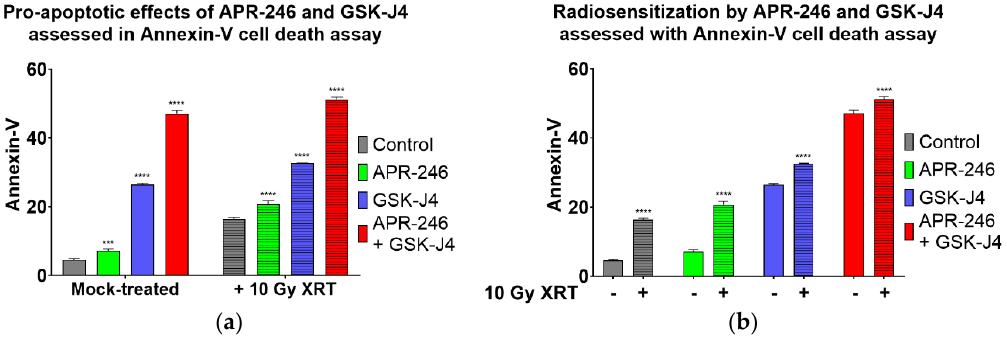
Figure 6. APR-246 combined with GSK-J4 induces apoptosis of H3.3 K27M DIPG cells following radiation treatment. Annexin V apoptosis assay with SF8628 H3.3 K27M DIPG cells. ( a ) Pro-apoptotic effects of APR-246 and GSK-J4 used as single agents (open bars on the left) or combined with XRT (crossed bars on the right), versus untreated cells; ( b ) Same experiment evaluating radiosensitization by comparing % Annexin-V cells treated with 10 Gy XRT vs. mock-treated cells. H3K27M DIPG cells were pre-treated with 5 µM of either APR-246, GSK-J4, or both, and subjected to a single 10 Gy dose of radiation. Cells were harvested 24 h post-irradiation and Annexin V cell death assay was carried